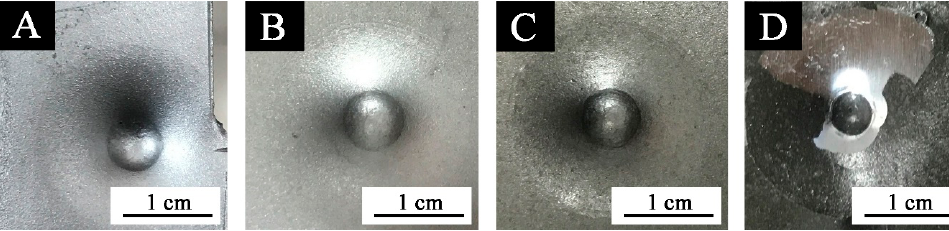
Figure 7. Images of coatings with different black paste content after impact resistance test: ( A ) 0%, ( B ) 1.0%, ( C ) 7.0%, and ( D ) 10.0%.